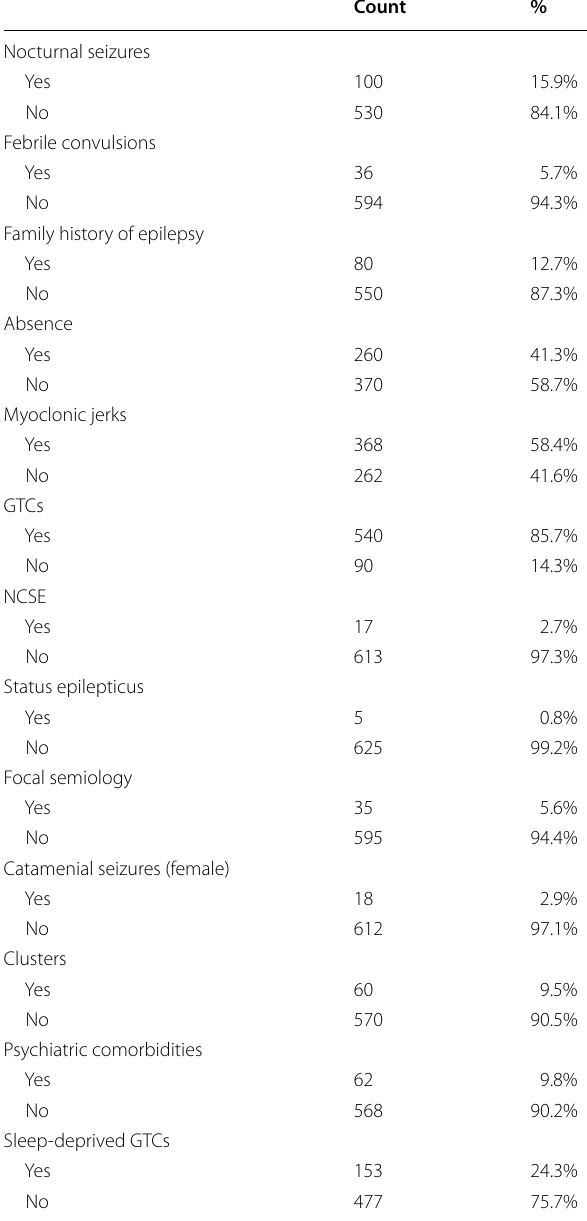
GTCs generalized tonic clinic seizures, NCSE non-convulsive status epilepticus